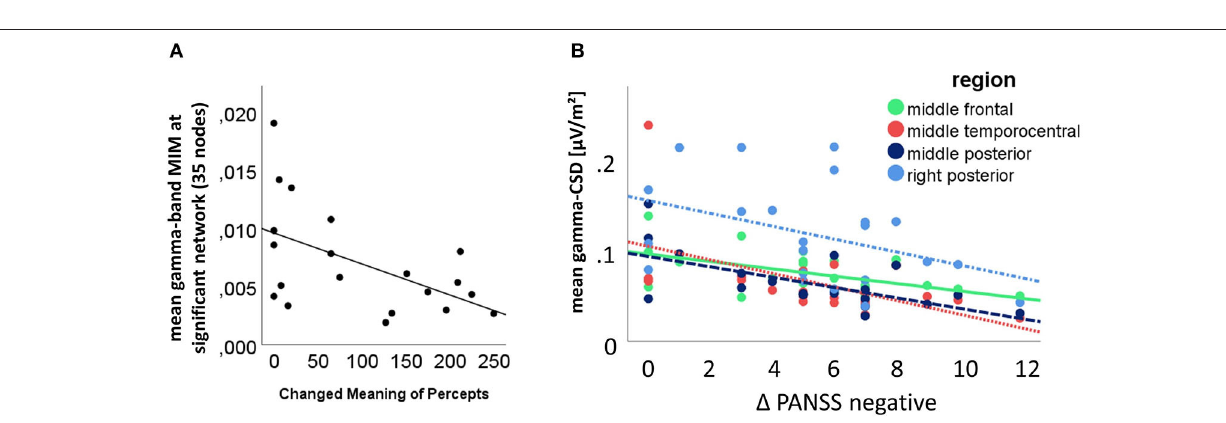
FIGURE 7 | (A) Significant multivariate analysis of variance result, with the mean connectivity within the significant 45 connections involving gamma-network as dependent variable and the 5D-ASC changed meaning of percepts scale as predictor (bivariate Pearson’s r = − 0.534; n = 21; p = 0.008); (B) Correlation between the CSD in the significant regions as revealed by the multivariate analysis of variance results and post-hoc t -testing; the bivariate correlations between PANSS-negative factor increase and the middle frontal region (solid green line) (Pearson’s r = − 0.541; n = 22; p = 0.005), the middle temporo-central region (densely dotted red line) (Pearson’s r = − 0.562; n = 22; p = 0.003), the posterior middle region (dashed dark blue line) (Pearson’s r = − 0.627; n = 22; p = 0.001) and the right posterior region (dashdotted light blue line) (Pearson’s r = − 0.412; n = 22; p = 0.028) were Bonferroni